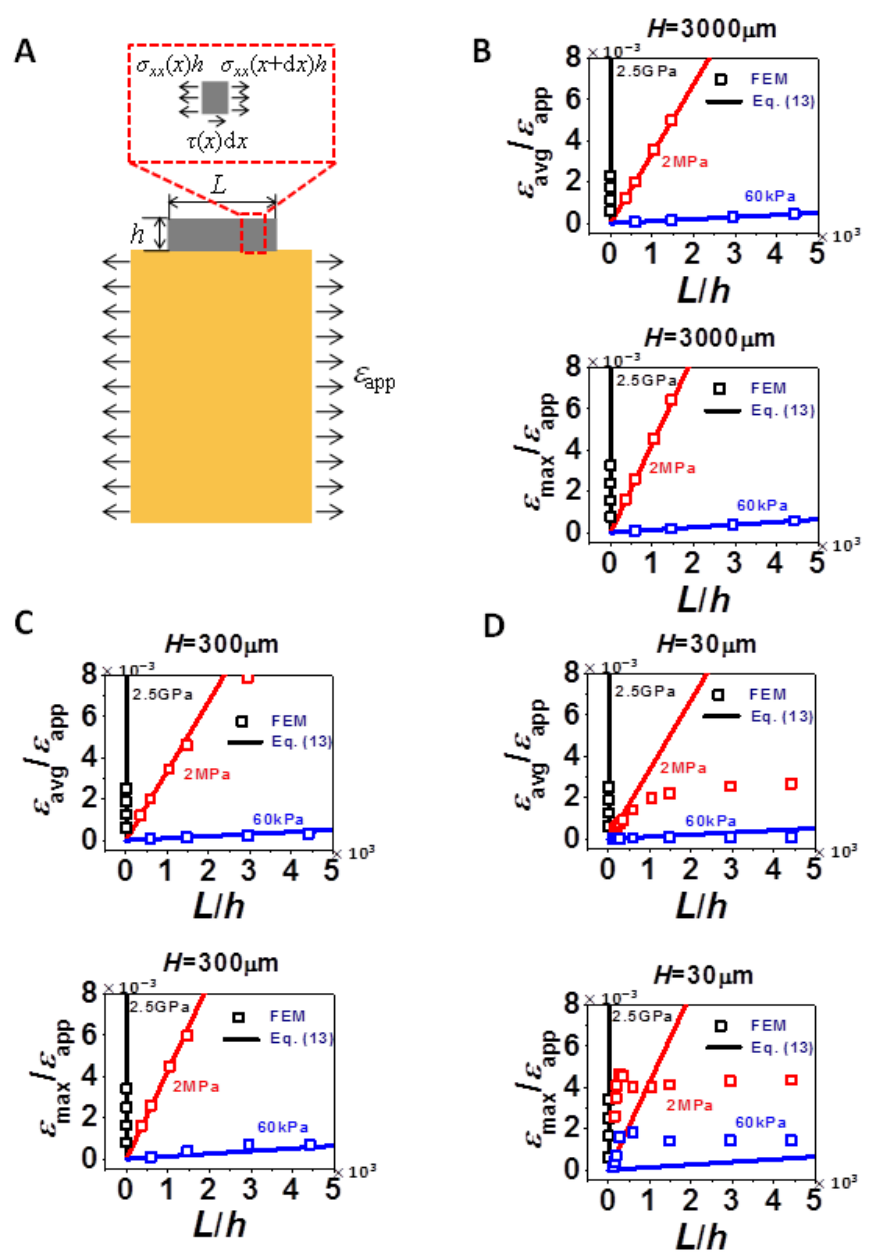
Figure 5. Comparison of Equation (13) and FEM results of ε L / H << 1. ( A ) Schematic of a thin silicon strip bonded to an infinitely thick substrate and the FBD of a thin slice of silicon. ( B ) ε and ε / ε for H = 300 μm. ( D ) ε max app Equation (13) works better for thicker and stiffer